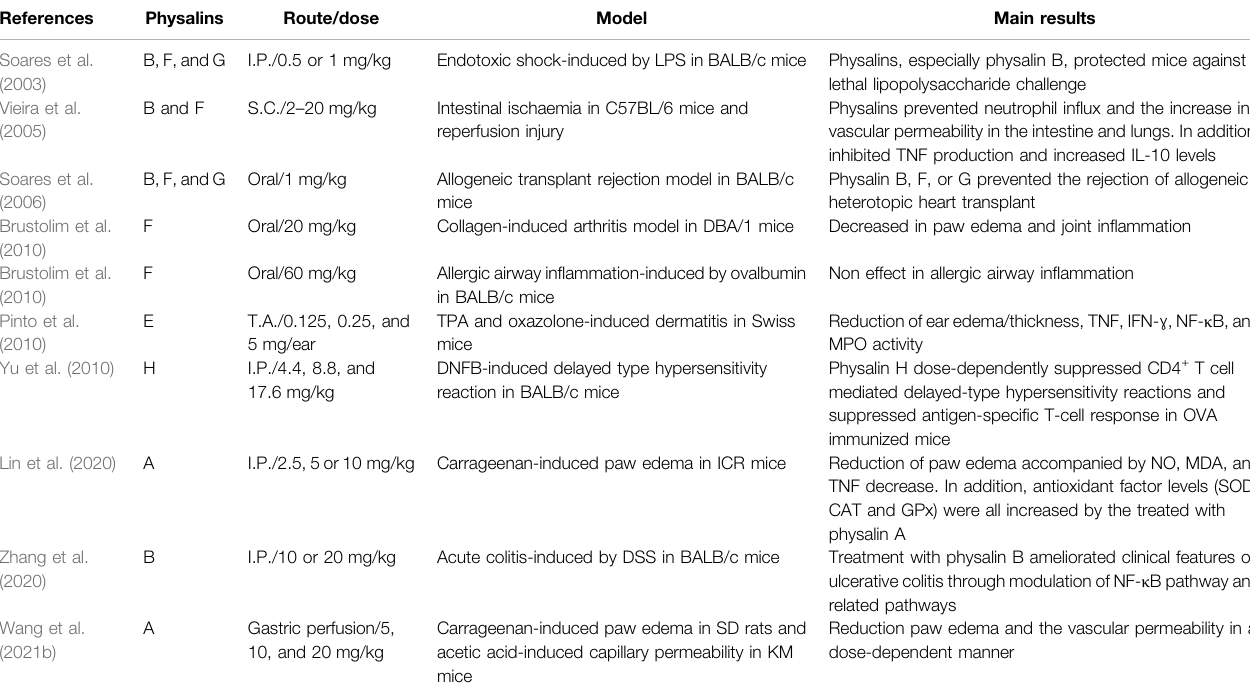
TABLE 2 | In vivo immunomodulatory activity of